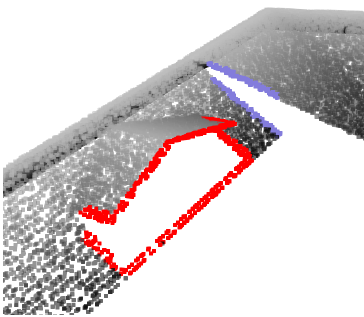
Figure 4. Visualisation of both types of considered height jumps, where the corresponding points of a dormer height jump are red, and the points of an internal height jump from Figure 3 are